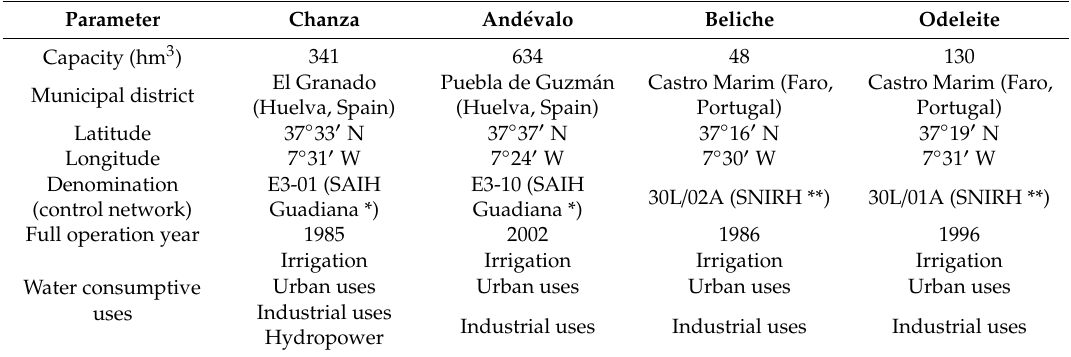
Table 1. Regulating reservoirs of the water resources system of the Lower Guadiana Transboundary Basin